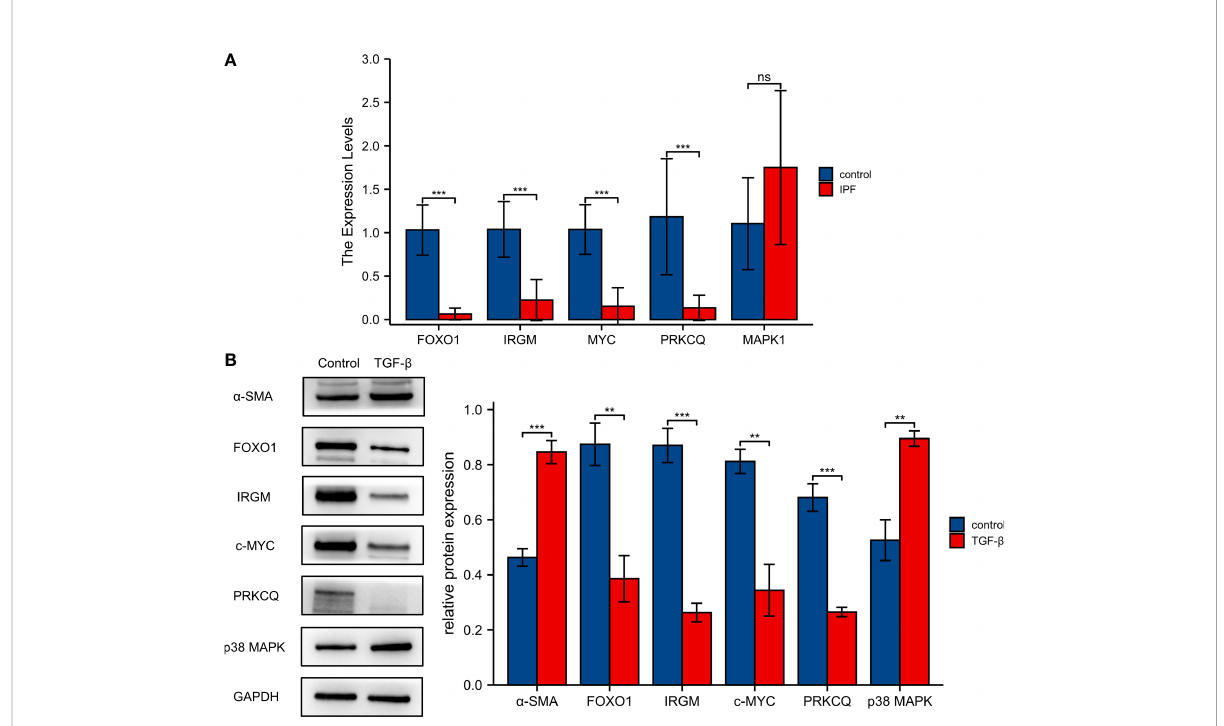
FIGURE 8 Validation of fi ve screened autophagy-associated genes. (A) Validation of mRNA expression levels of FOXO1 , IRGM , MYC , PRKCQ , and MAPK1 with qRT-PCR. (B) The protein expression of FOXO1, IRGM, MAPK1, MYC , and PRKCQ was detected by western blotting. **p< 0.01, ***p< 0.001, and ns, no signi fi